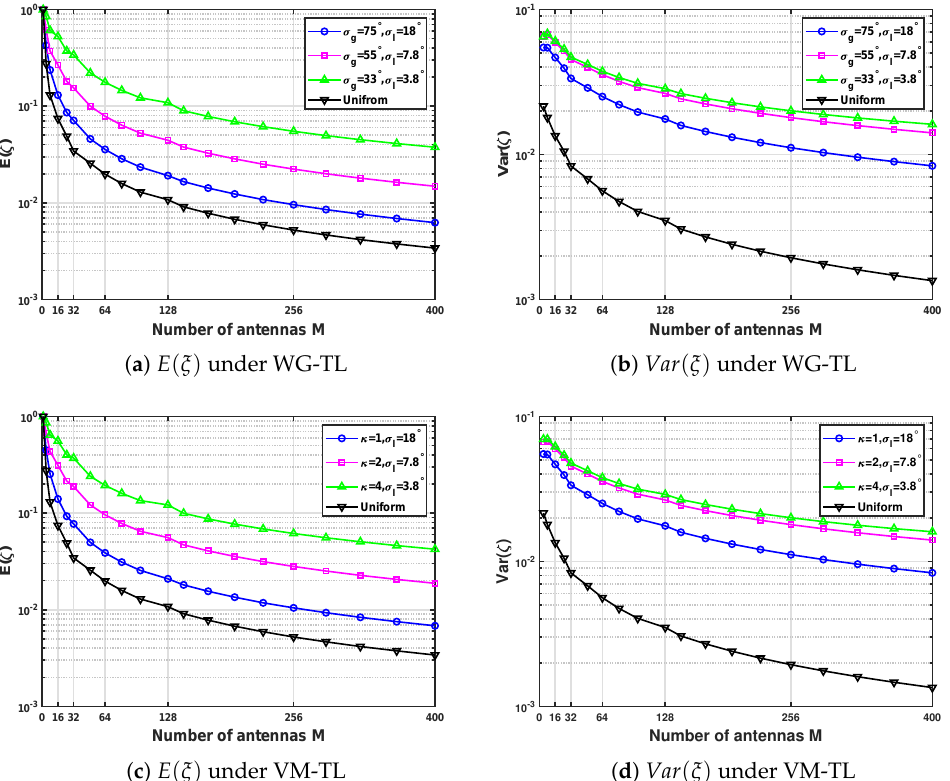
Figure 3. Expectations and variances against the antenna number M , angle spread σ and concentration factor κ under WG-TL and